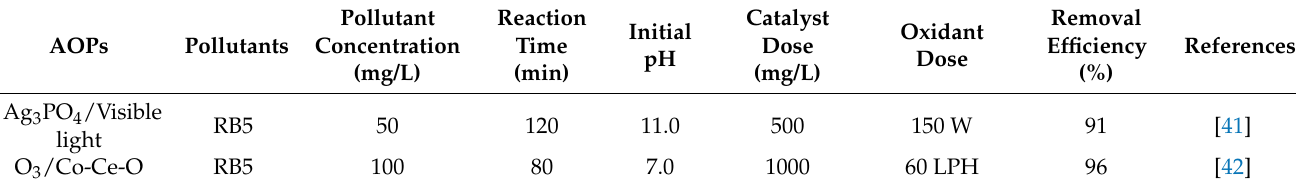
Table 1. Comparison of different AOPs in removing RB5, ANL, and PVA with Fe 2+ /PAA/H 2 O 2 sys- tem.